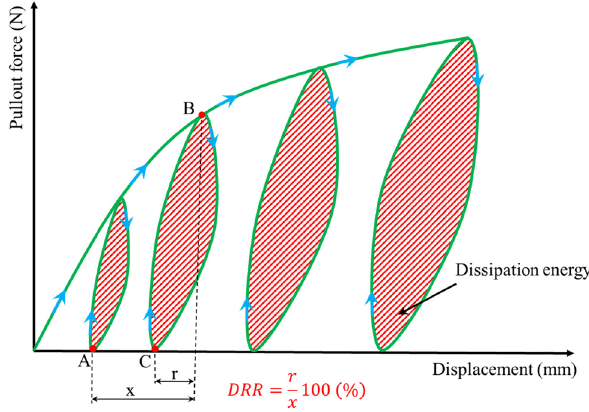
Figure 6: Pullout response of crimped fi ber with 1.0 mm